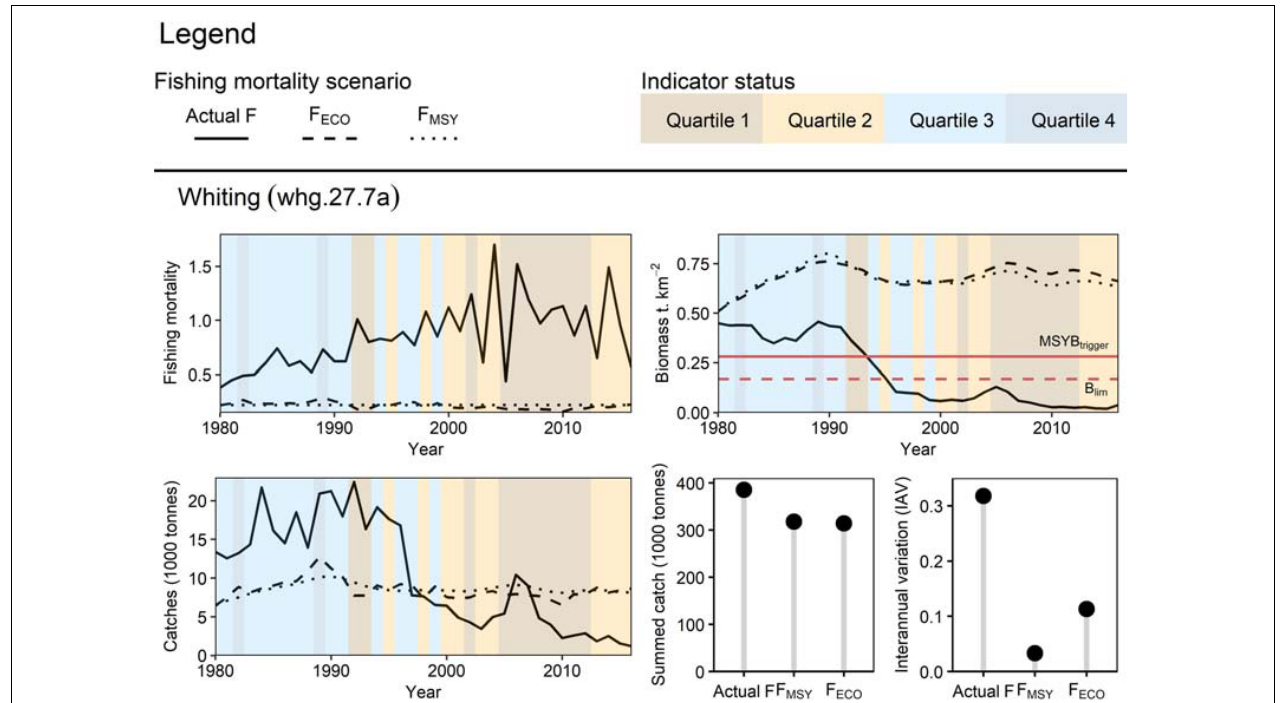
FIGURE 8 | Retrospective application of F ECO for Irish Sea whiting: Three fishing mortality scenarios were prepared to simulate Irish Sea whiting dynamics from 1976 to 2016. F ECO was retrospectively calculated based on the condition of the sea surface temperature (3-year lag) indicator. The different fishing mortality trends were applied to whiting in the EwE model to simulate their effect on the stock’s biomass and catch (trend, total yield and interannual